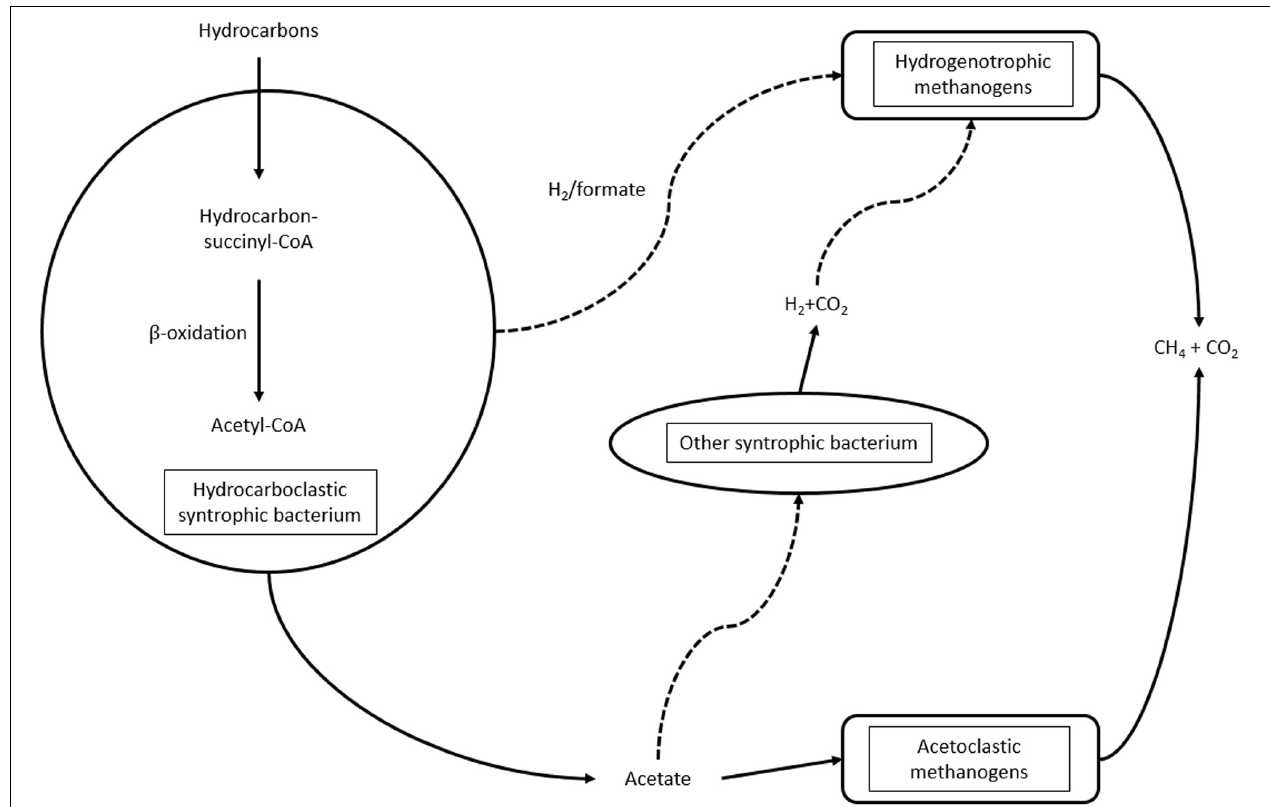
FIGURE 2 | Syntrophic interactions during hydrocarbon biodegradation under methanogenic